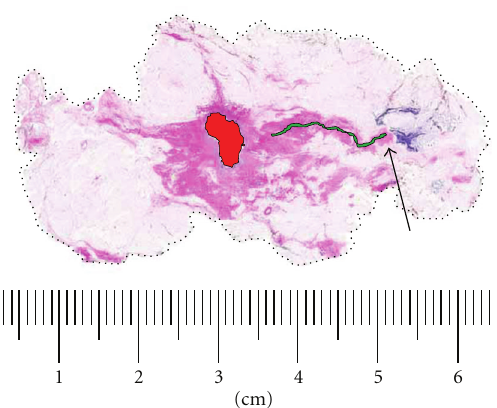
circumferential surgical margin (broken line). Biopsy cavity is centrally located (solid red). Grade 2 DCIS (solid green) extends 15mm from the cavity to within 9mm of true surgical margin. Arrow marks migration of India ink into specimen to within 1mm from DCIS. A conventional histologic section taken in this area could misrepresent the margin distance as 1 mm. This pitfall is easily avoided on the large-format slide. Scale: small divisions = 1.0mm